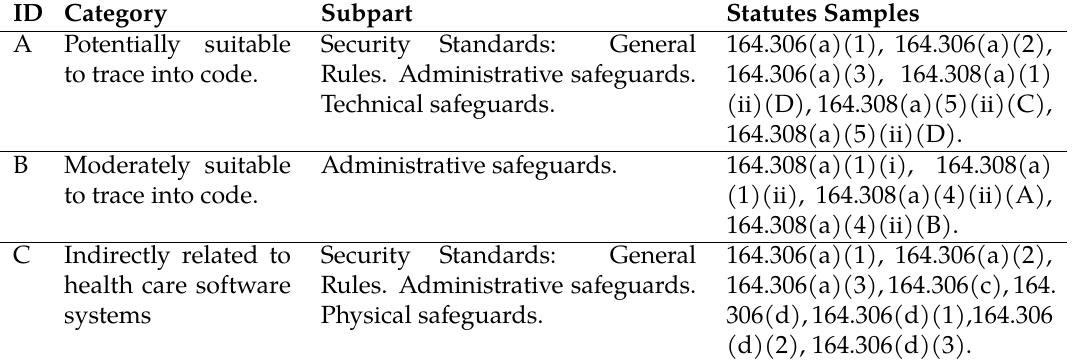
Table 1: HIPAA Statutes